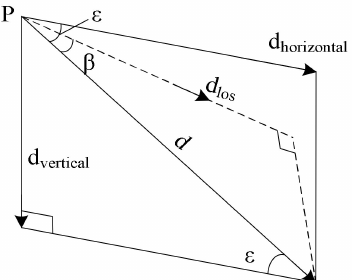
Figure 8. The spatial relationships between d vertical , d , d horizontal , and d los .